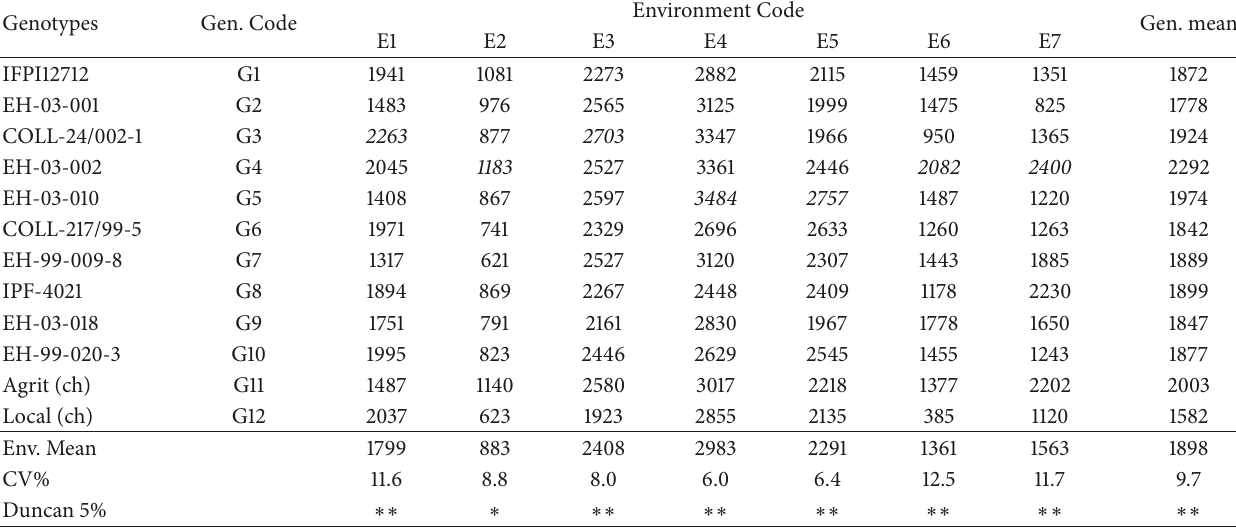
Table 2: Mean grain yield (Kg ha −1 ) of twelve field pea genotypes over seven environments (i.e., across two locations and four years).